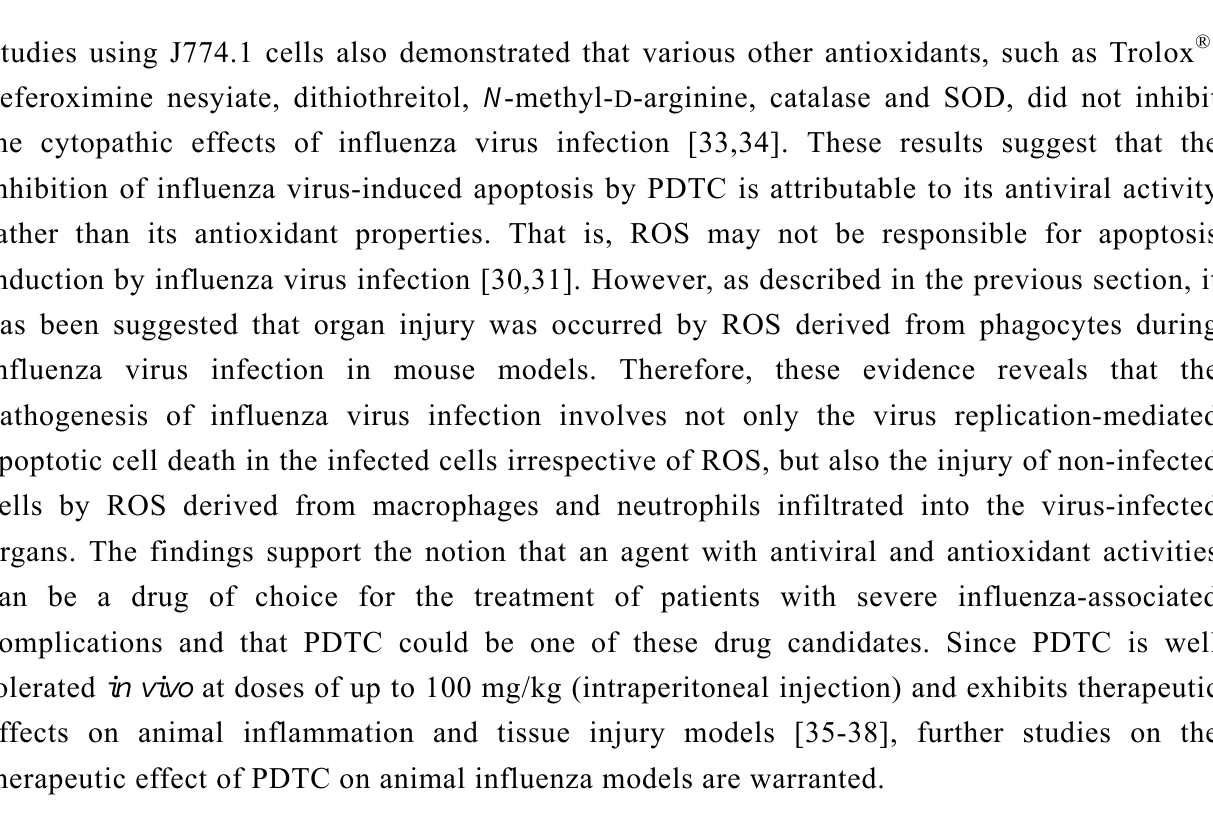
Figure 3. Thiol antioxidants with anti-influenza virus